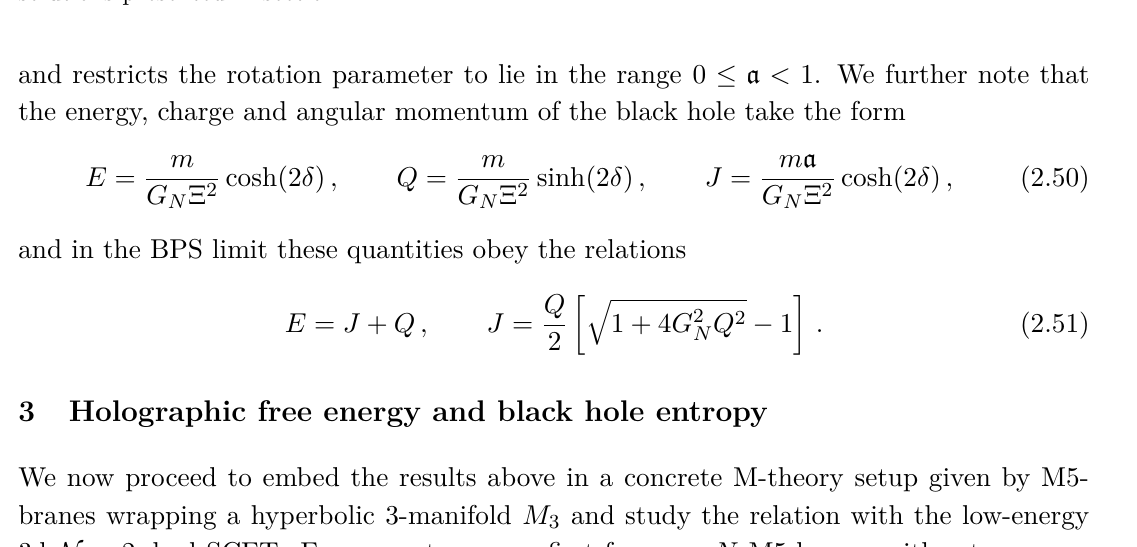
Table 1 . The values of ( F , χ ) appearing in the on-shell action (2.7) for the three classes of Euclidean solutions presented in section